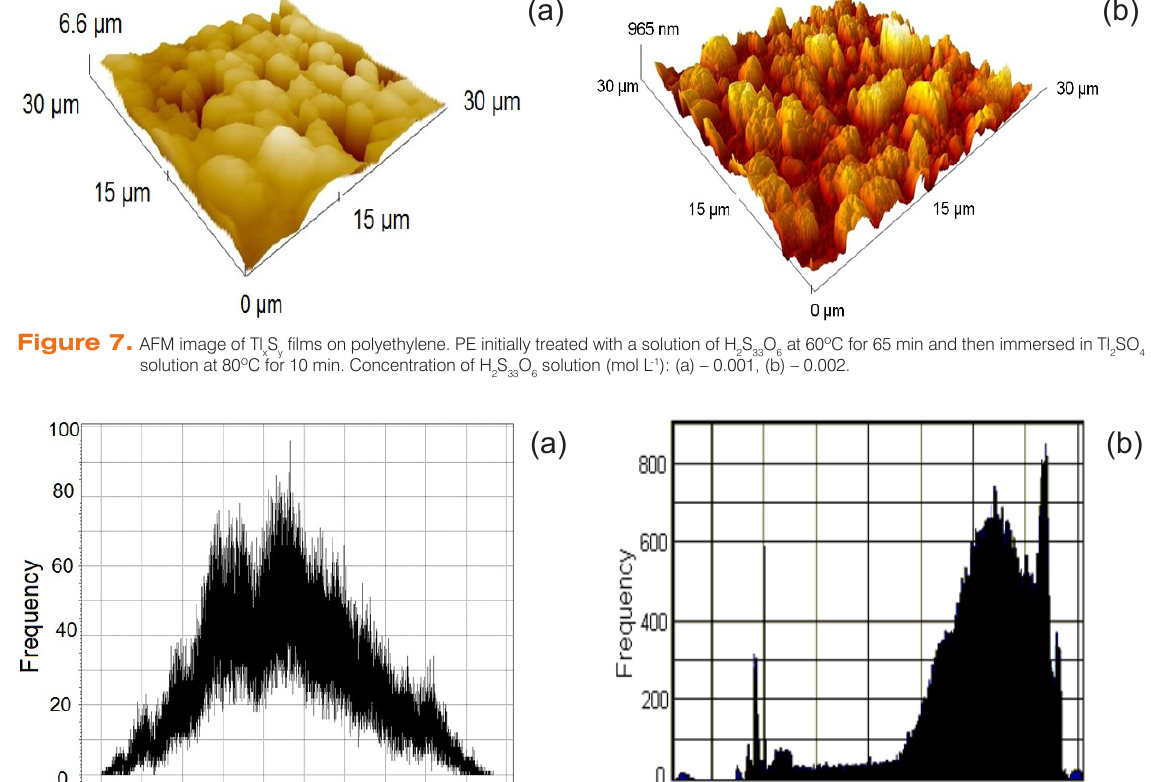
S O at 60ºC for 65 min and then 2 33 6